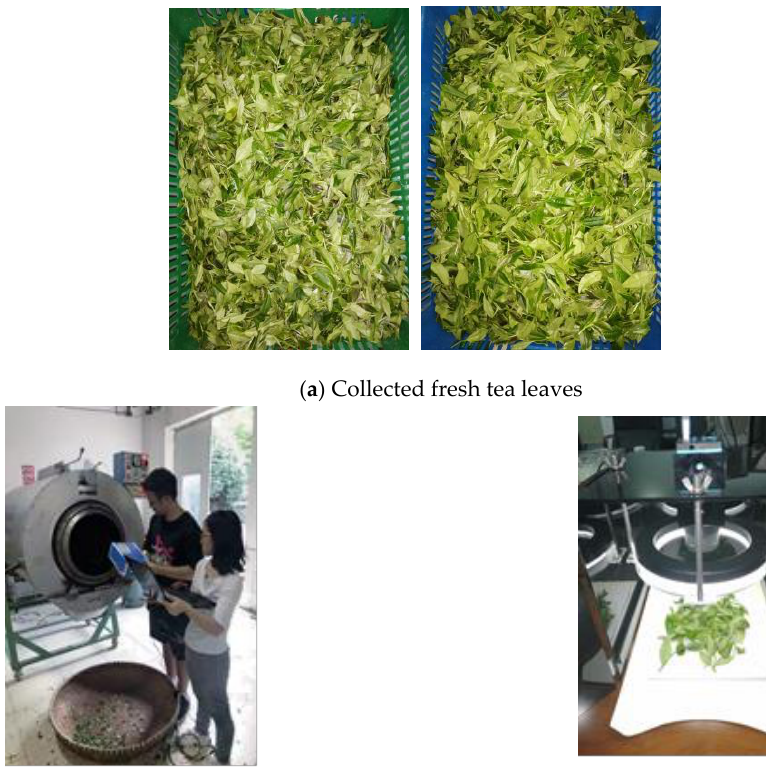
Figure 9. Acquisition of experimental samples.